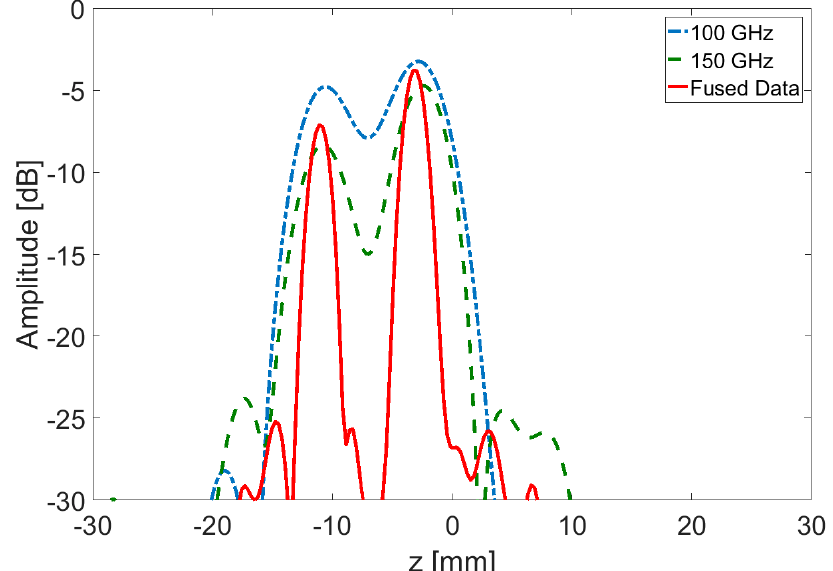
Figure 7. Depth measurement of a plastic sample showing reflection peaks in the measurement signals from the front and backside of the sample. While the reflections from the two layers are almost blurred and reaching the Rayleigh resolution limit for the two individual measurements at 100 GHz (40 GHz bandwidth, blue) and 150 GHz (60 GHz bandwidth, green dots), the fused data (red) with enhanced synthetic bandwidth of 100 GHz clearly resolves the two reflection peaks.